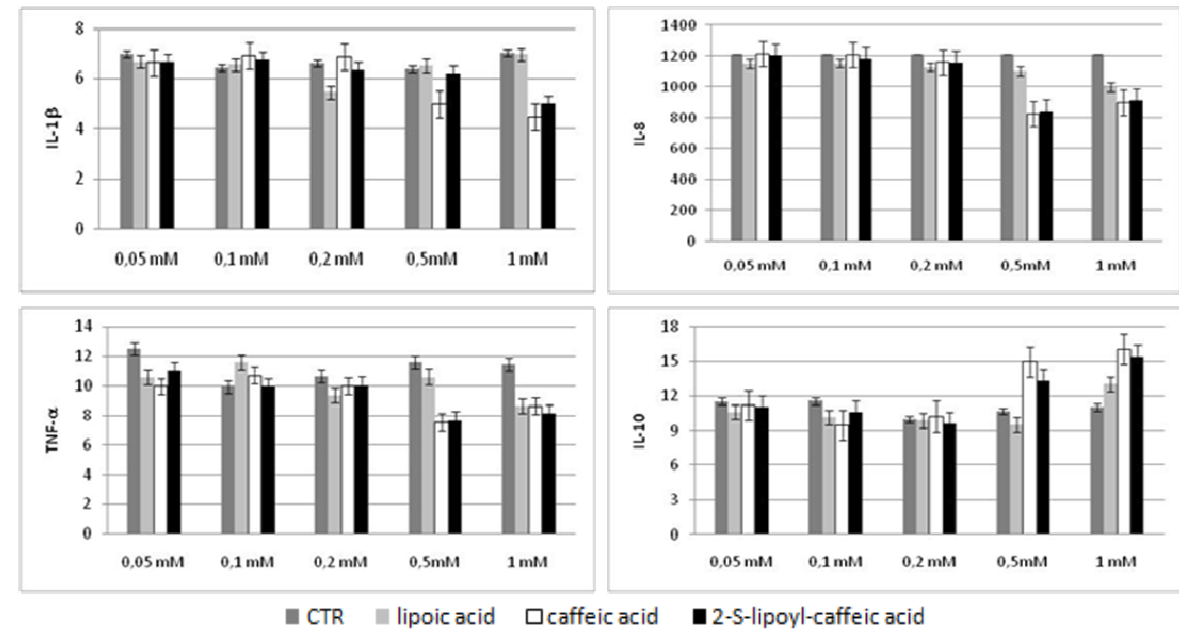
Figure 4. Cytokines levels in Huh7 cell line after 48 h of treatment.